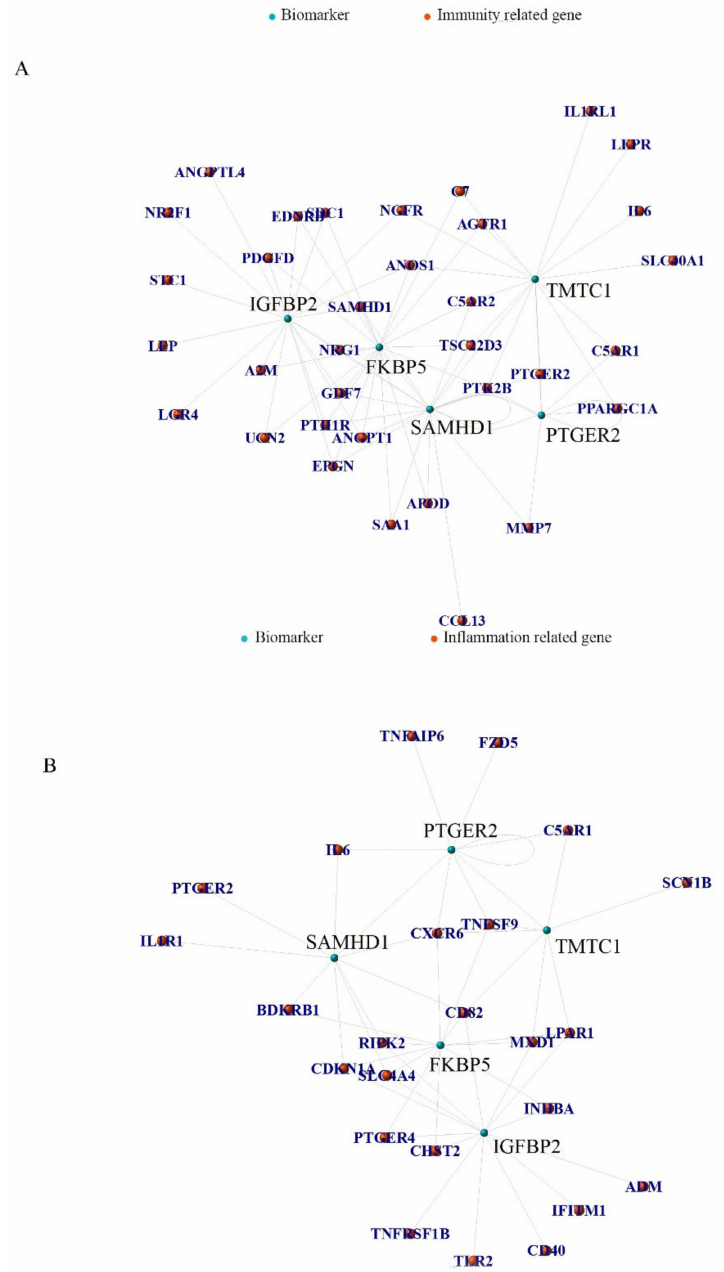
Figure 11. ( A ) Relationship between differentially expressed immunity related genes and selected biomarkers. ( B ) Relationship between differentially expressed inflammation related genes and selected